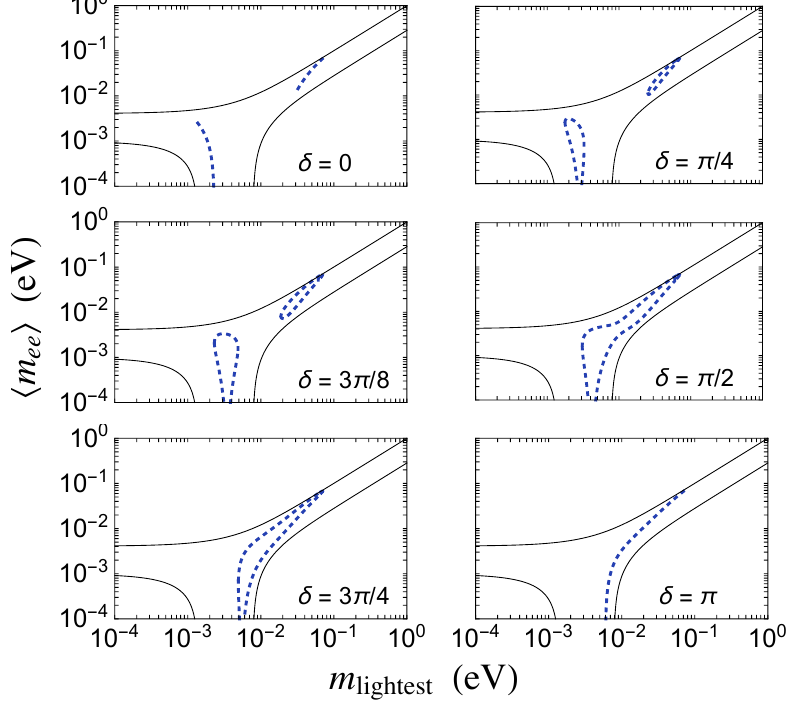
Figure 2 . The e(cid:11)ective mass h m ee i from the SO(10) constraint of eq. (2.10) for di(cid:11)erent values of the Dirac phases (cid:14) , in the case of Normal Hierarchy. The dotted lines correspond to the allowed values in the m lightest { h m ee i plane when using the best-(cid:12)t values of neutrino mixing parameters [9].